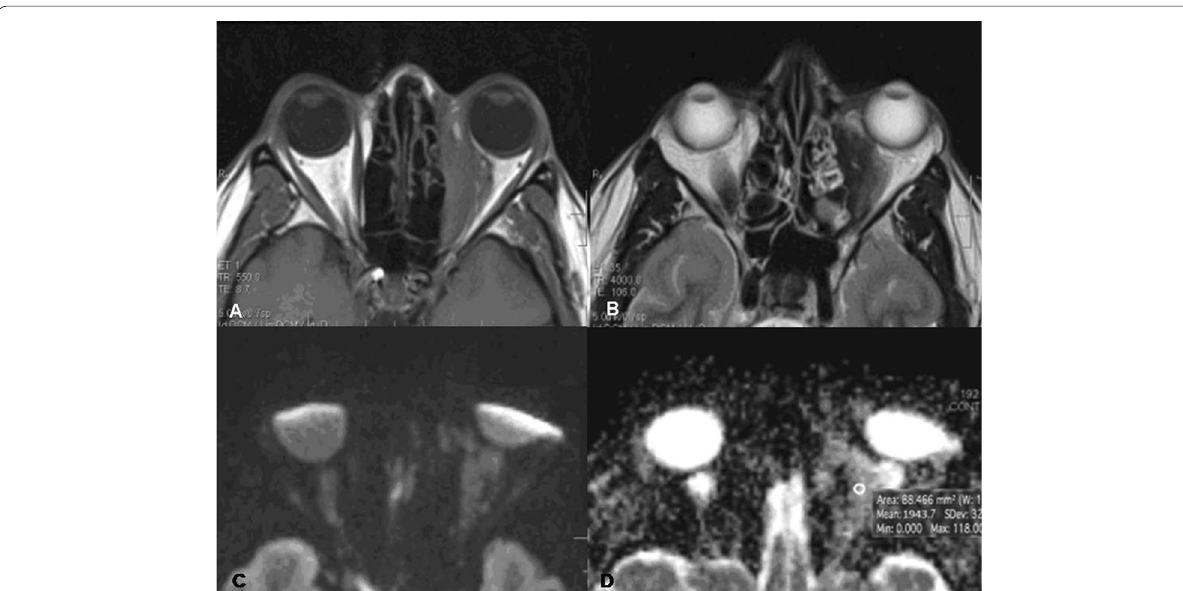
Fig. 4 A 35-year-old female patient with acute rhino-sinusitis presented with left-sided orbital pain, mild proptosis and limited orbital movement. Axial T1- and T2-weighted images of the left orbit A , B show a primarily extraconal mass involving the left medial rectus muscle with intraconal extension. No diffusion-weighted restriction seen on DWI (b 500 ) image ( C ) and ADC ( D ). The ADC value for the mass is 1.09 Histopathologically proved left-sided orbital inflammatory pseudotumor by FNAC